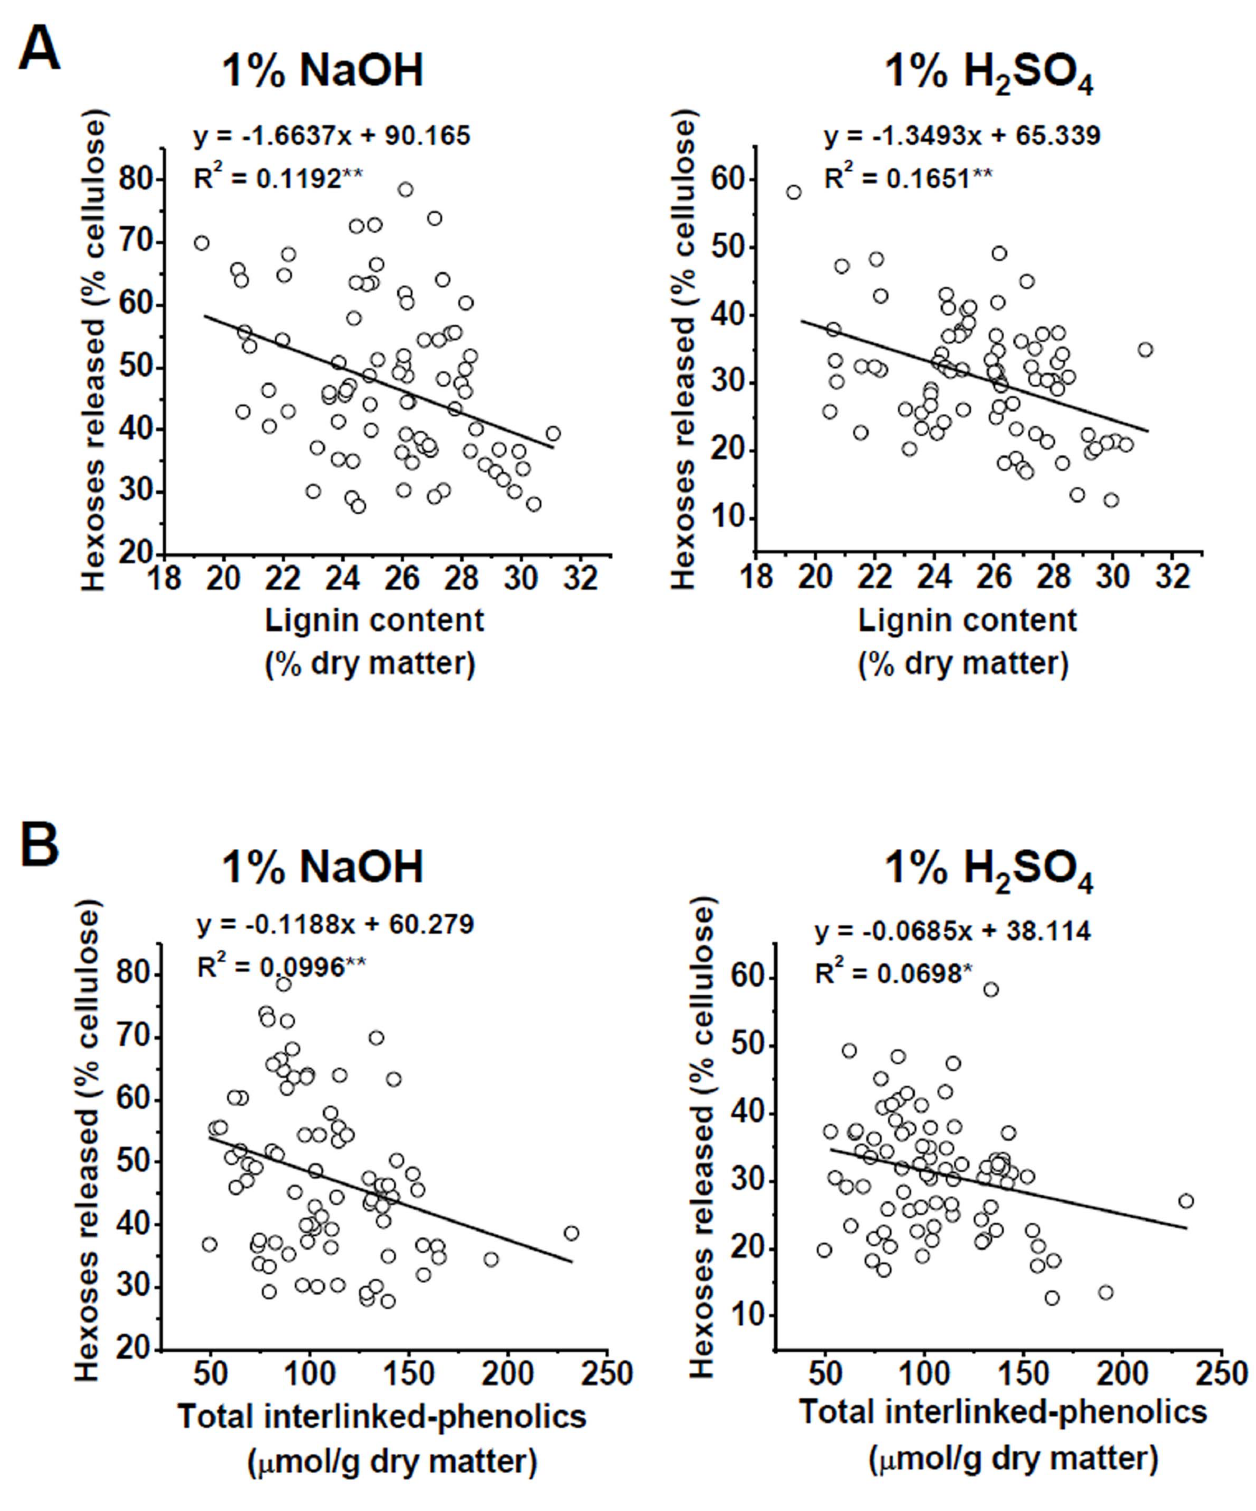
Figure 3. Correlation analysis among lignin, interlinked-phenolics and biomass saccharification in Miscanthus . (A) Correlation between lignin content and hexoses yield; (B) Correlation between total interlinked-phenolics and hexoses yield. * and ** Indicated the significant correlation coefficient values at p , 0.05 and 0.01 (n=79), respectively.